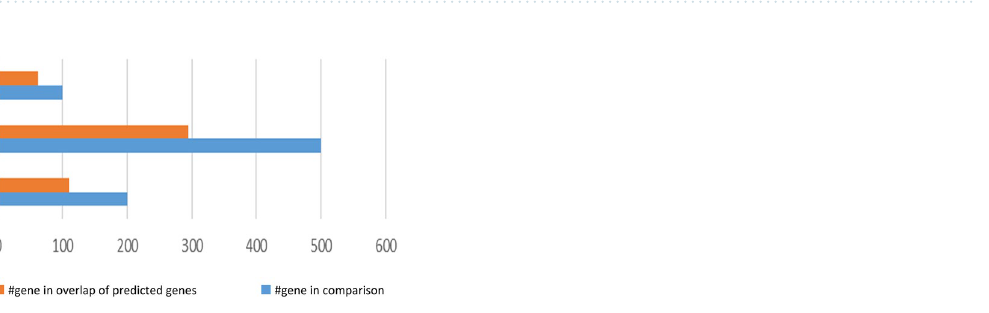
Figure 4. Comparing p -values between the previous and the proposed methods for an average of a subset of 200 driver genes.